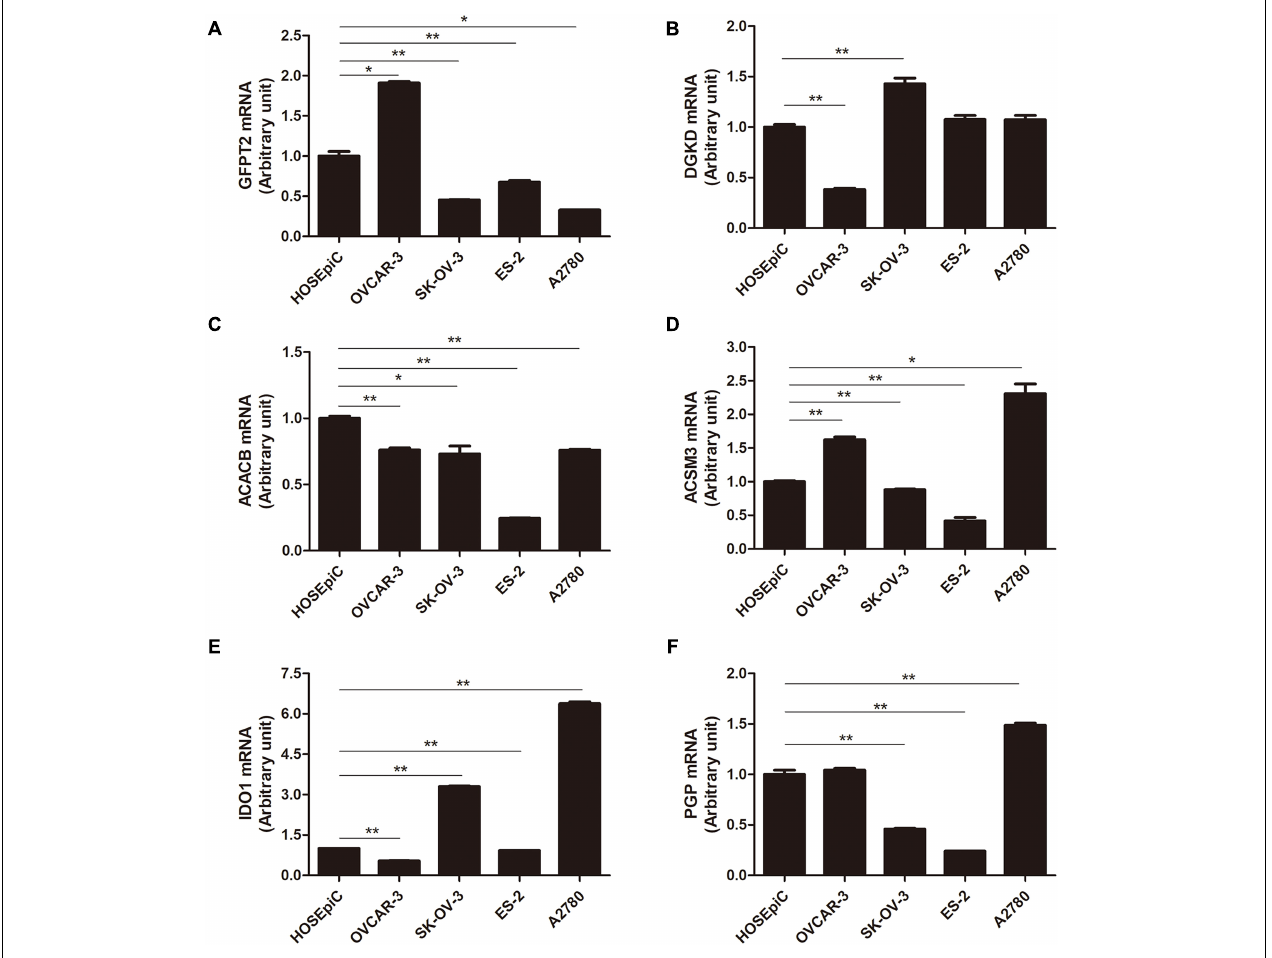
FIGURE 4 | The mRNA level of six hub genes in normal ovarian cell line and OC cell lines by qRT-PCR. (A) GFPT2, (B) DGKD, (C) ACACB, (D) ACSM3, (E) IDO1, and (F) PGP. * P < 0.05, ** P <